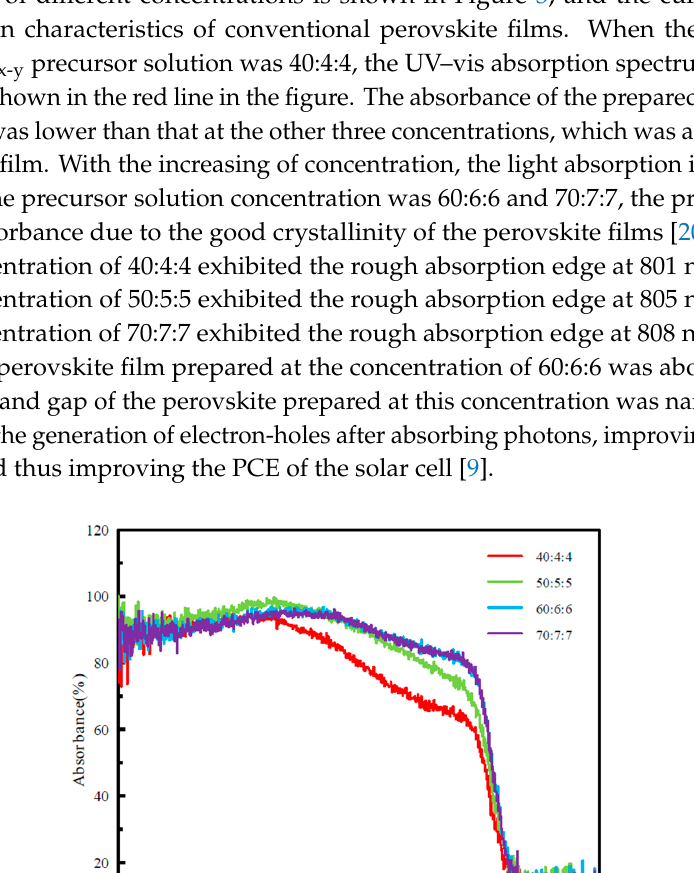
Figure 4. Photoluminescence spectroscopy of perovskite layers prepared with different concentrations of formamidine methylamine halide precursors solutions. The device structure prepared on the indium tin oxide (ITO) conductive substrate in this experiment